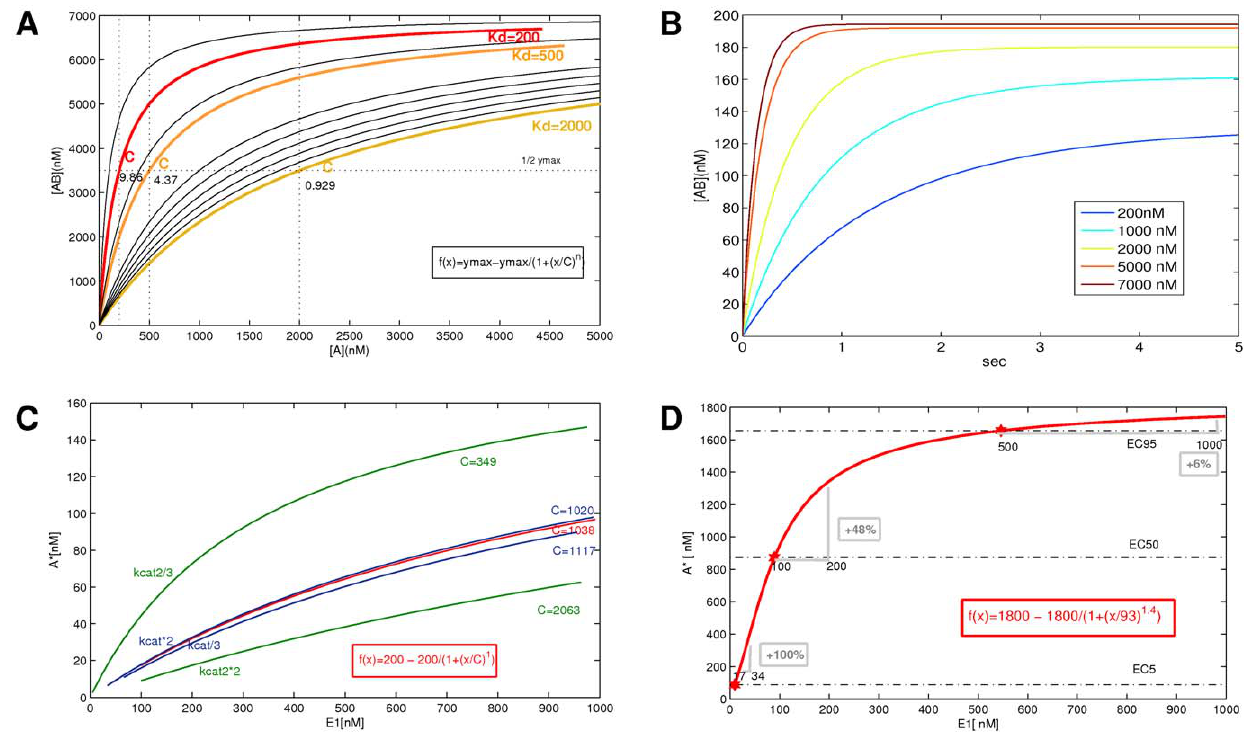
Figure 1. Properties of psf functions. A. Complex formation: Psfs were generated for ½ A (cid:1) z ½ B (cid:1) < ½ AB (cid:1) with Kd ~ 200,500,2000 , ½ A (cid:1) 0 ~ 10 nM { 10 m M ; ½ B (cid:1) 0 ~ 7 m M , and fitted with the saturating hyperbolic function shown in the figure. For an elementary reaction, C ~ Kd . All and n=1. The slope at C indicates the signal transmission strength. B. Dynamics of other curves were generated only by varying C, where y max ~ ½ B (cid:1) 0 ~ 200 nM ; ½ A (cid:1) ~ 200 nM { 7 m M . Increasing concentrations for the source species ½ A (cid:1) complex formation: ½ A (cid:1) z ½ B (cid:1) < ½ AB (cid:1) with Kd ~ 200 , ½ B (cid:1) speeds 0 0 0 =200, k on =0.00026; k off =1.5; k cat =30.4; k cat 2 =0.26 up the reaction. C. Enzymatic Reactions with Reverse Reaction: Example reaction with ½ A (cid:1) 0 (shown in red) and variations (shown in green, blue). Both the forward reaction ( k cat ) and reverse reaction ( k cat 2 ) parameters are varied by 30%–200%. Variability in signal transmission is expressed by the fitted parameter C (half-maximal activation) in a uniform way. D. Signal Transmission Strength: A 100% increase of input yields diminishing increases at higher concentrations. Signals are shown at EC5, EC50 and EC95.